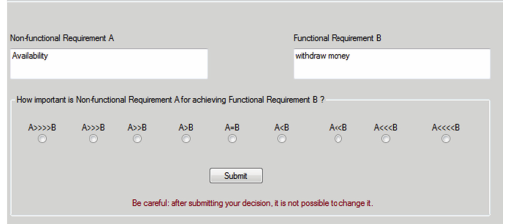
Figure 6: A snapshot of the graphical user interface showing a pair of nonfunctional and functional requirements (availability, withdraw money) under evaluation in CHAM.